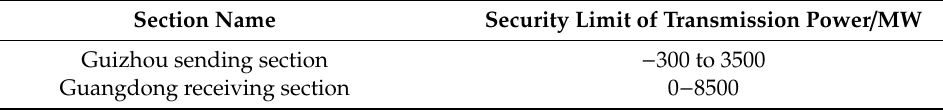
Table 2. Security operation limits of key AC transmission